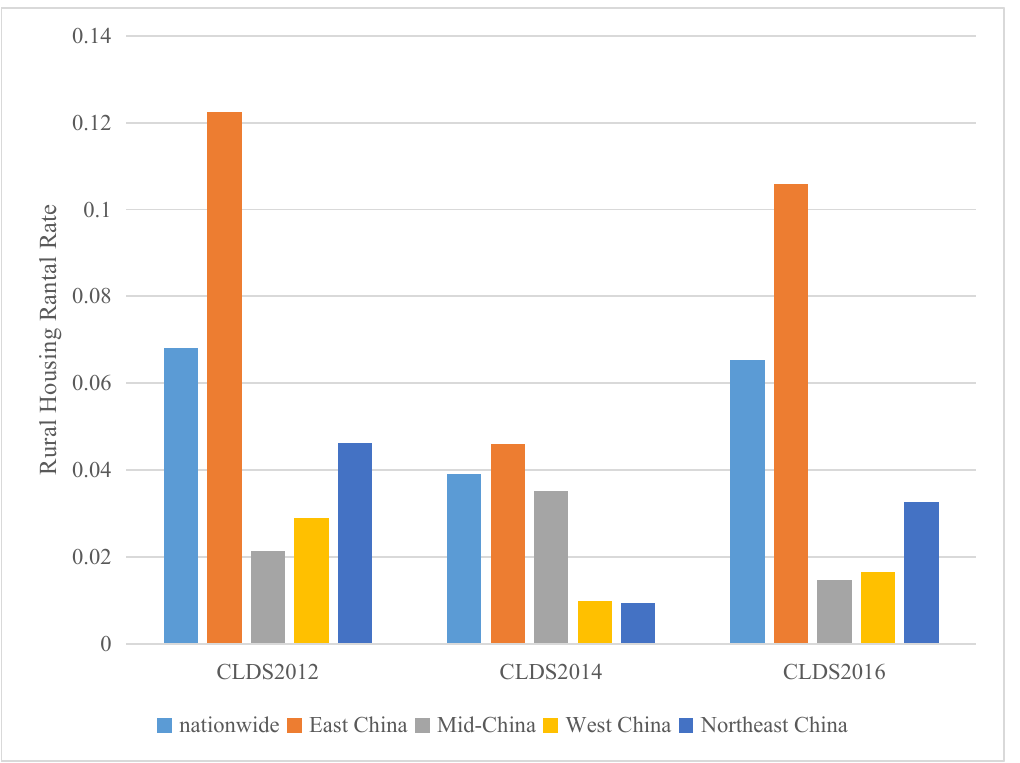
Figure 1. General characteristics of the rural housing rental rate.